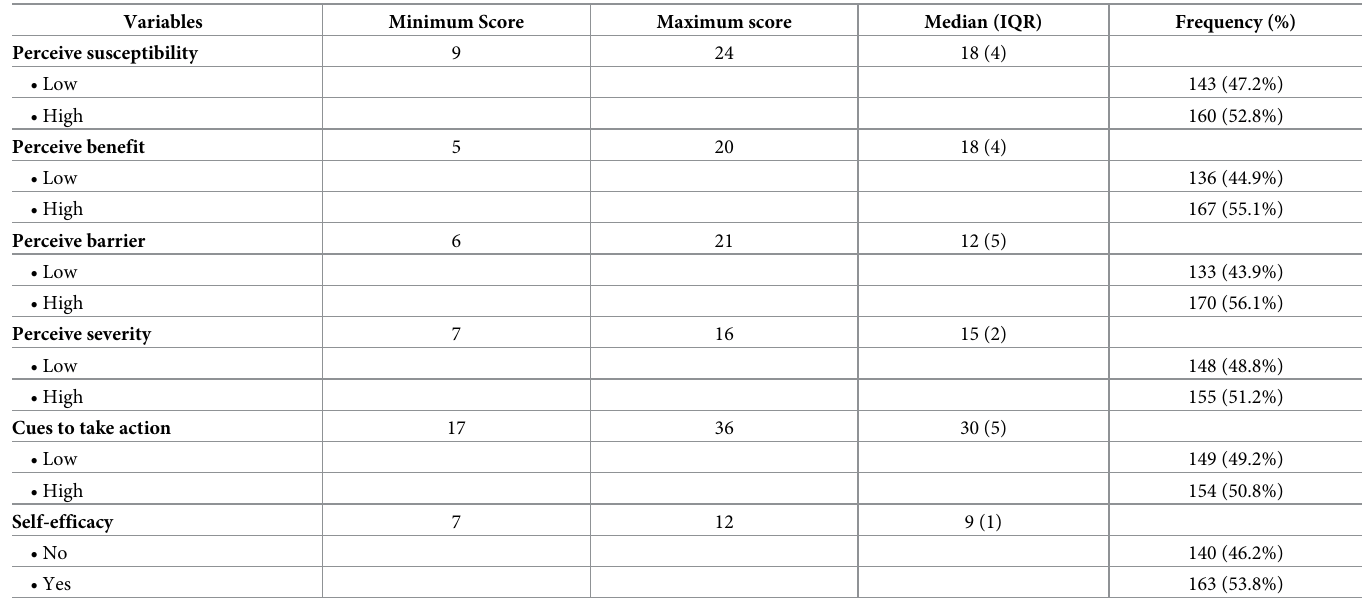
Table 2. Scores and level of perceived susceptibility, perceived benefit, perceived barrier, perceived severity, self-efficacy, and cues to take